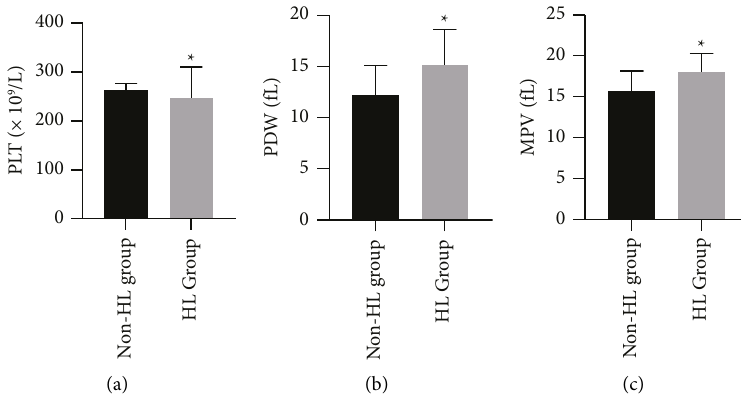
Figure 3: Comparison of platelet indexes. Note : ∗ indicates P < 0 . Table 2: Correlation analysis of each parameter of TEG and coagulation indexes in the HL group. Indicators/parameters